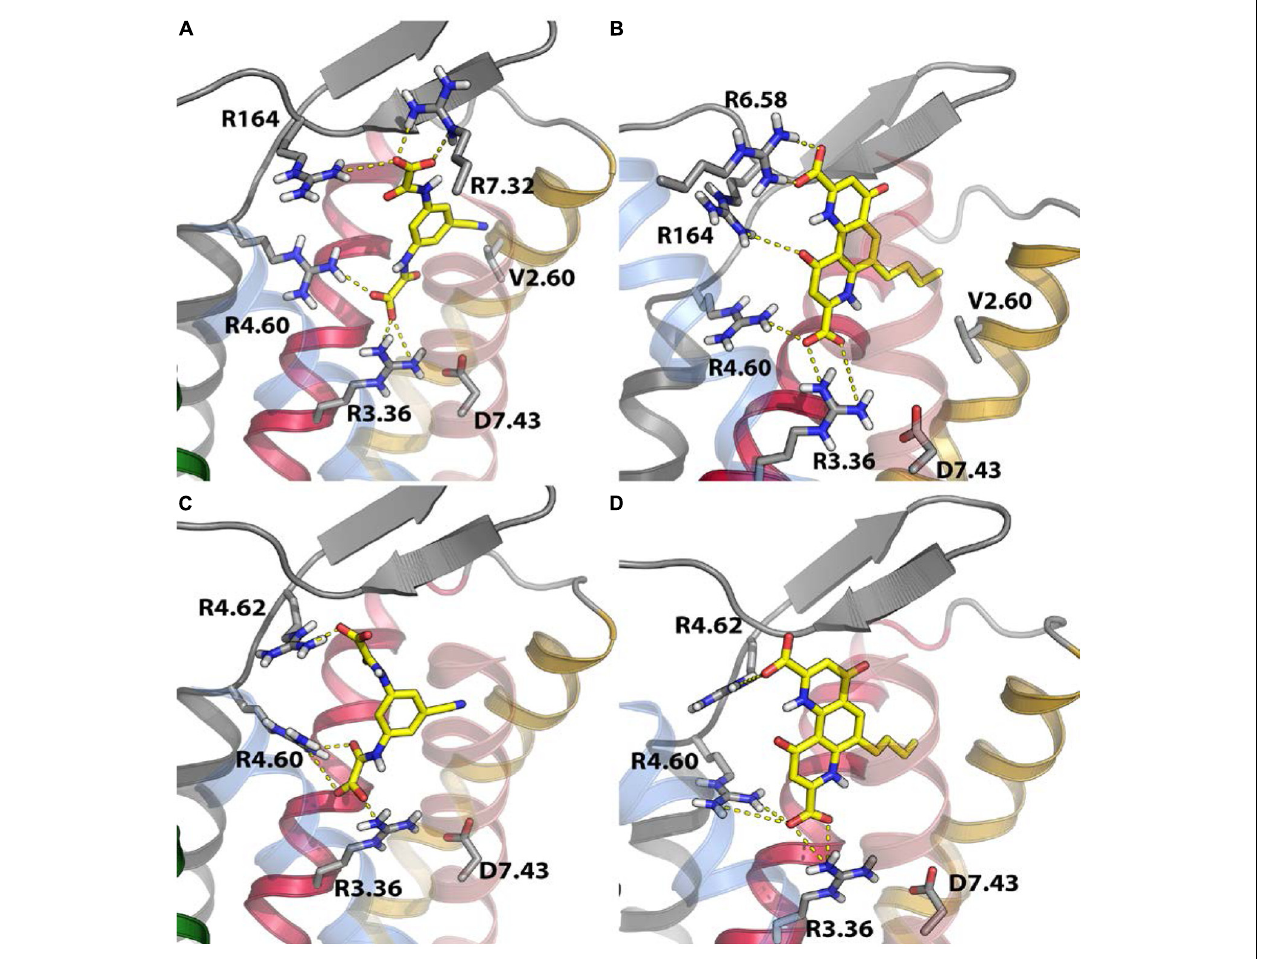
FIGURE 1 | Receptor homology modeling of human and rat GPR35 indicates residues important for ligand binding. Based on homology modeling efforts with the protease-activated receptor 1 and mutagenesis